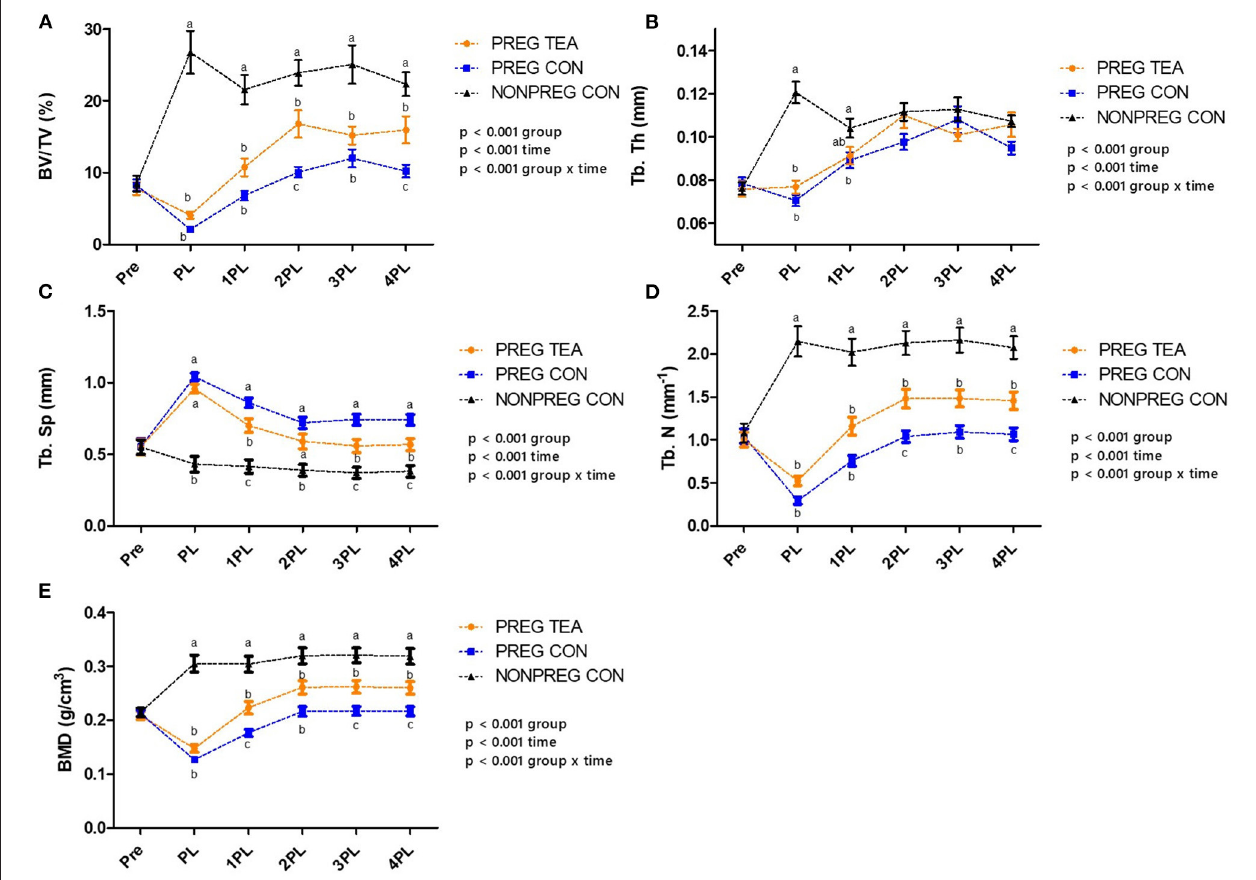
FIGURE 4 | Comparisons of trabecular outcomes for PREG TEA, PREG CON, and NONPREG CON; (A) BV/TV, (B) Tb. Th, (C) Tb. Sp, (D) Tb. N, and (E) BMD. Values are mean ± SEM, n = 13 or 14/group. Differing letters denote a significant difference among groups within a time point. Pre, pre-pregnancy; PL, post-lactation; 1PL, 1 month post-lactation; 2PL, 2 months post-lactation; 3PL, 3 months post-lactation; and 4PL, 4 months